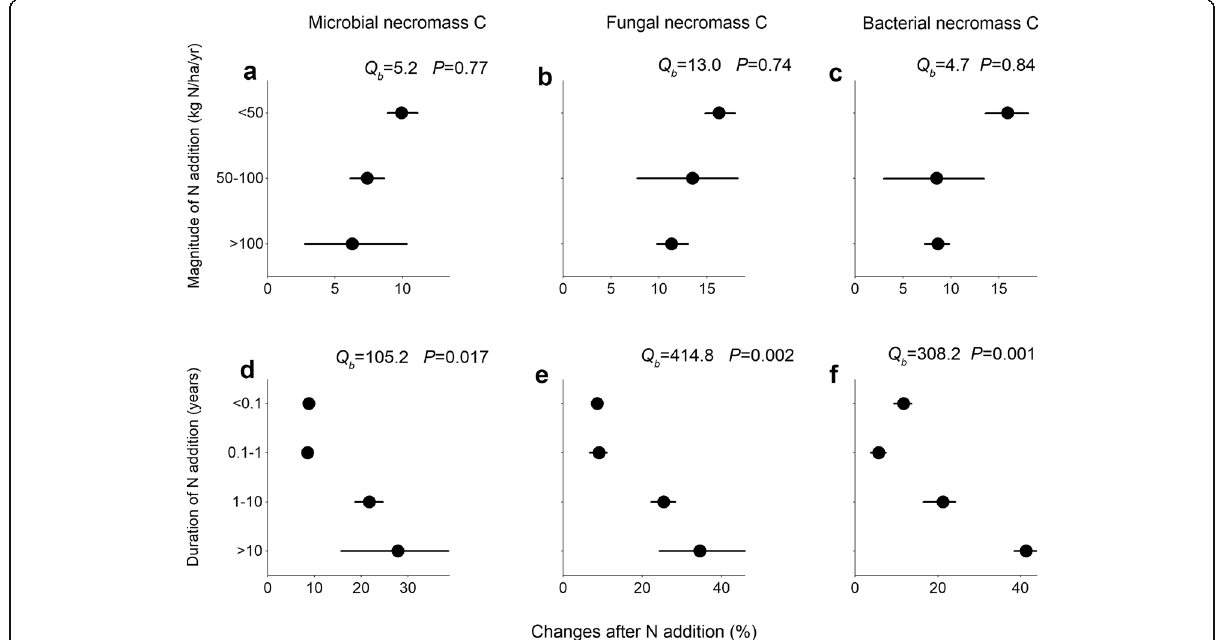
Fig. 4 Percent changes in microbial necromass C under different magnitudes (upper) and durations (lower) of N addition. a , d Total microbial necromass C, b , e fungal necromass C, and c , f bacterial necromass C. Error bars represent the 95% bootstrap confidence intervals that were calculated by weighted effect sizes. The responses of these variables to different magnitudes and durations of N addition are considered significant ( P < 0.05) if the 95% bootstrap confidence intervals do not overlap with zero. The between-group heterogeneities ( Q b ) and the probabilities ( P ) of the effects of N addition on microbial necromass C across different magnitudes and durations are shown in each panel